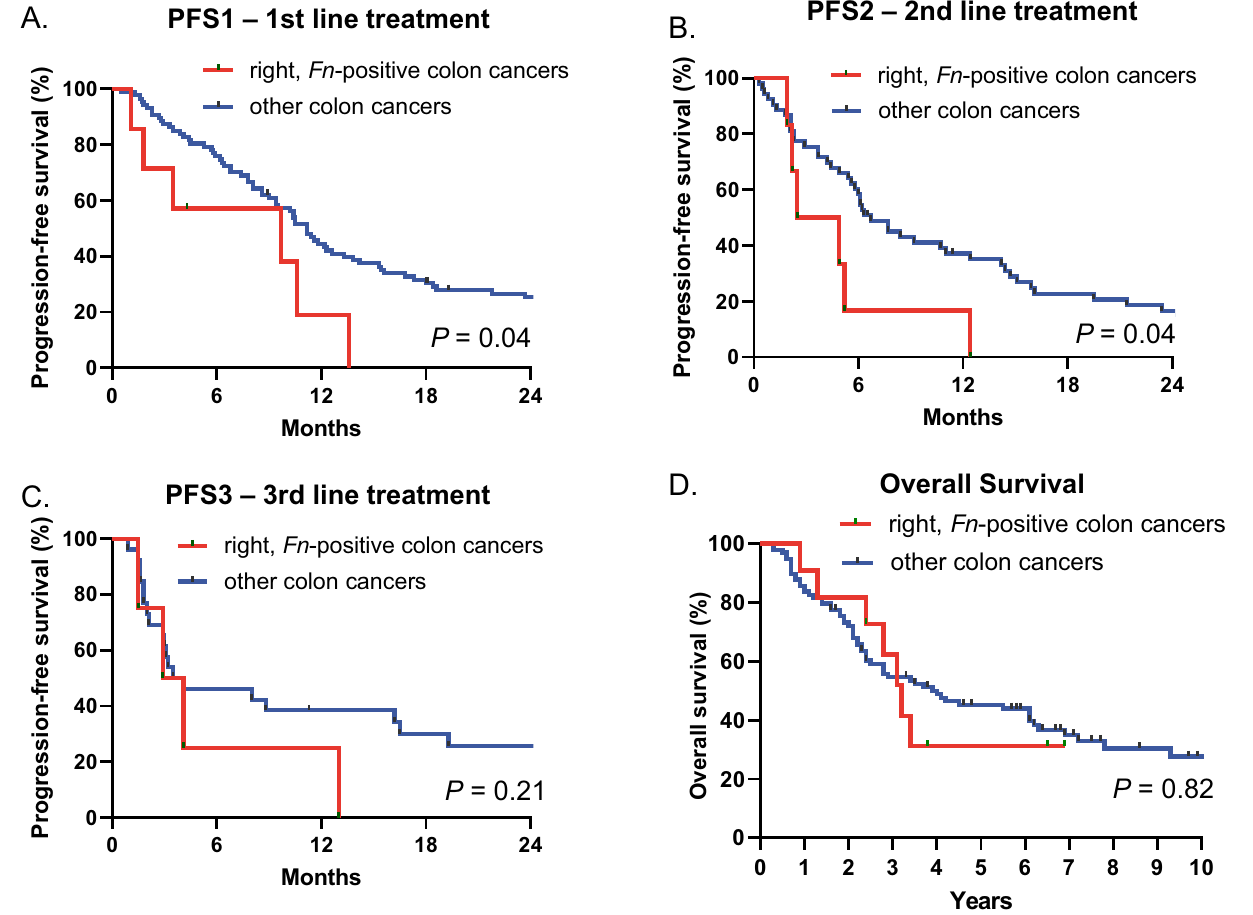
Figure 2. Kaplan–Meier curves of progression-free survival (PFS) in the ( A ) first (PFS1)-, ( B ) second (PFS2)-, ( C ) third (PFS3)-line palliative treatment, and ( D ) overall survival (OS) for Fn enriched, right-sided colon versus others. Others include (1) Fn enriched, left-sided colon cancer, (2) Fn negative, right-sided colon cancer, and (3) Fn negative, left-sided colon